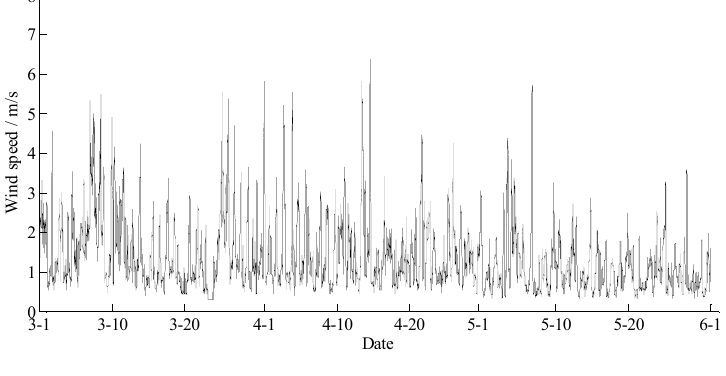
Figure 9. The curve of wind speed in Yan’er Ridge.